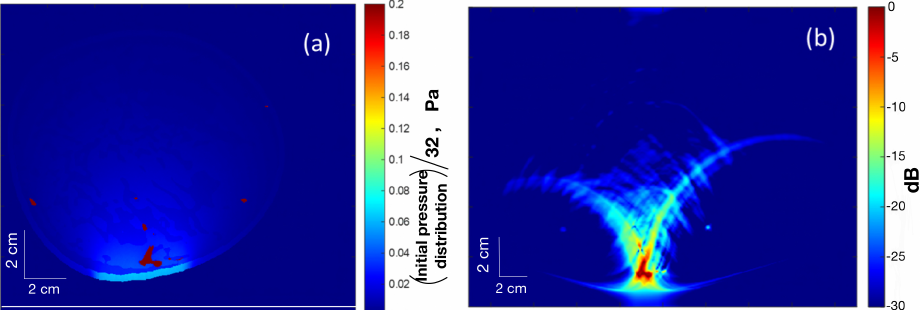
Figure 4. ( a ) Map of (squeezed color range) the initial pressure distribution ( P 0 ) with a linear array transducer at the bottom (white line) for PA reconstruction. ( b ) The reconstructed PA